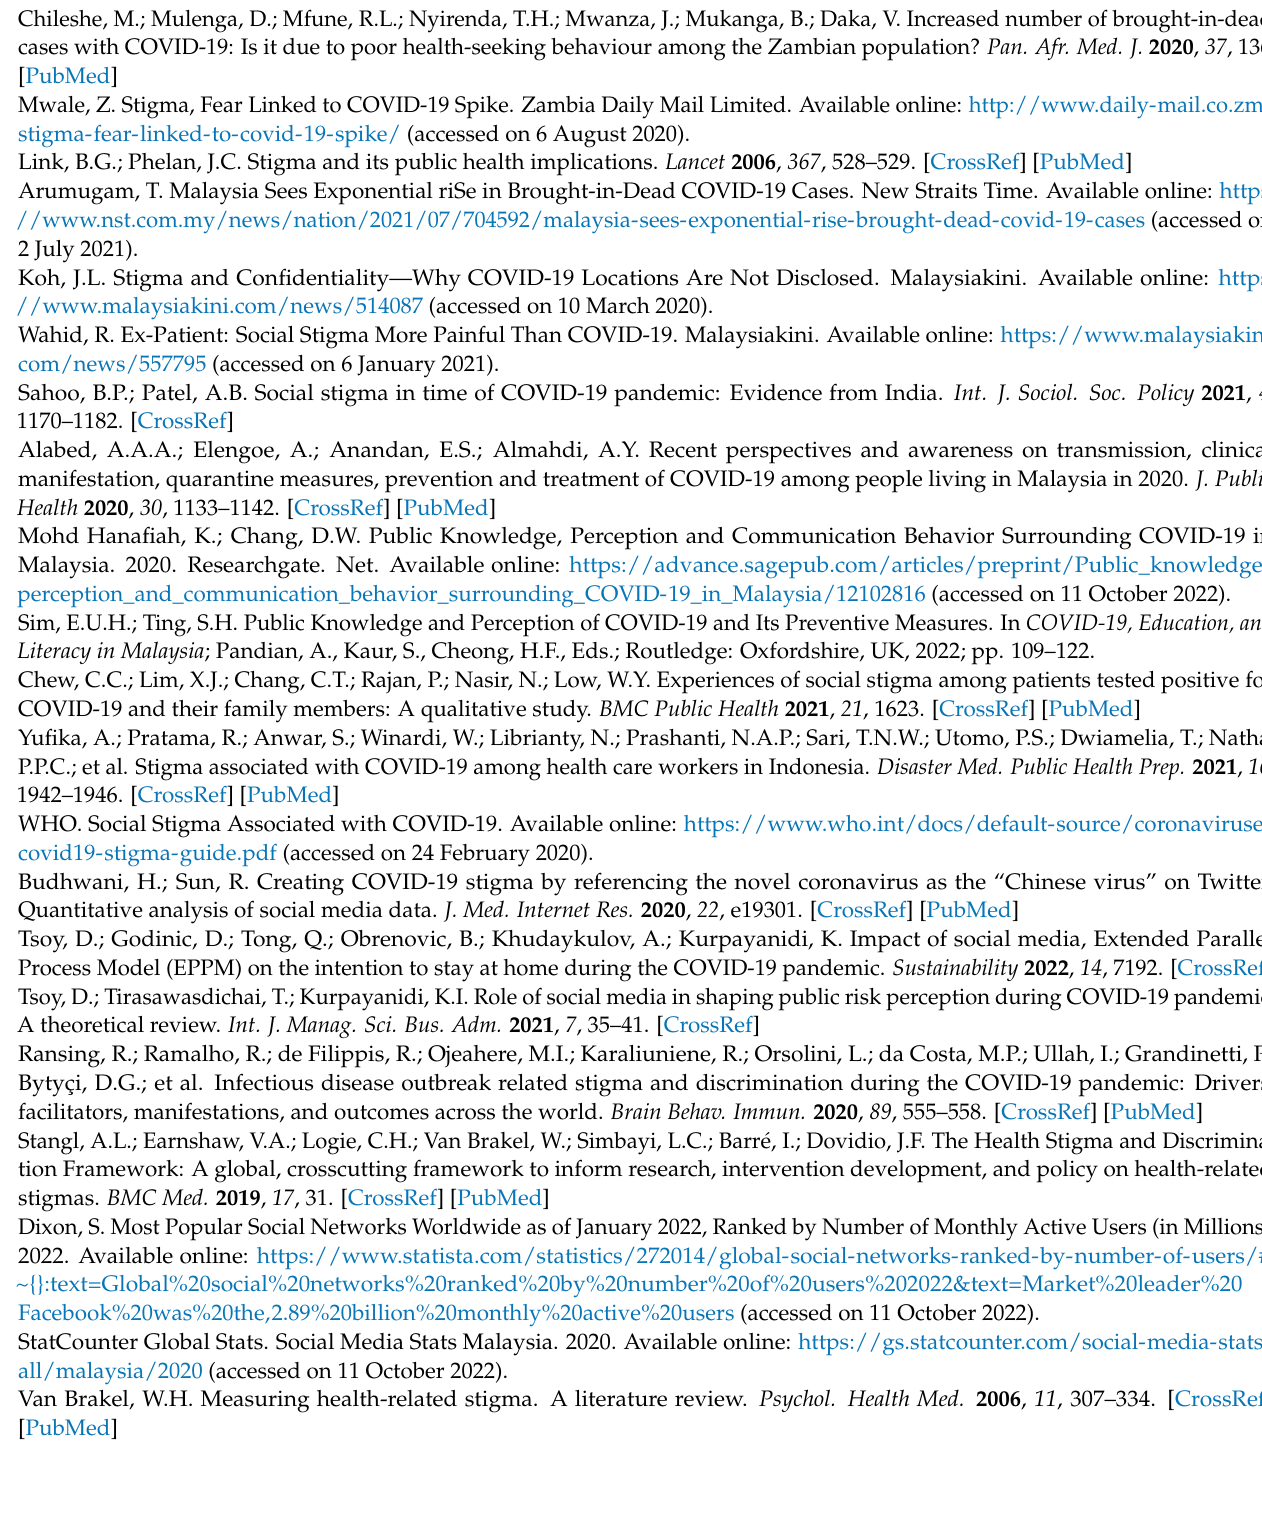
Table A6. Tweet stigmatising COVID-19 patients from certain occupations (N = 1). Tweet Twitter 66 pulang ke rumah masing2, adakah keberangkalian ahli keluarga dijangkiti sekiranya mereka positif COVID. (Bolding shows words stigmatizing COVID-19